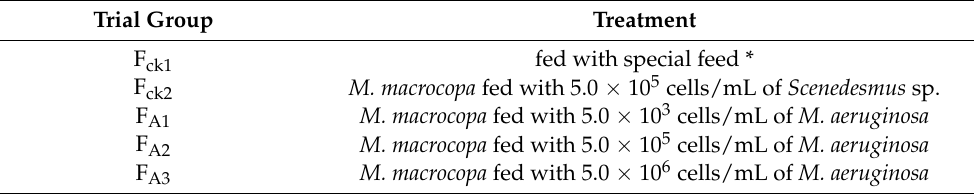
Table 1. The MC content in red carp was designed in different experimental